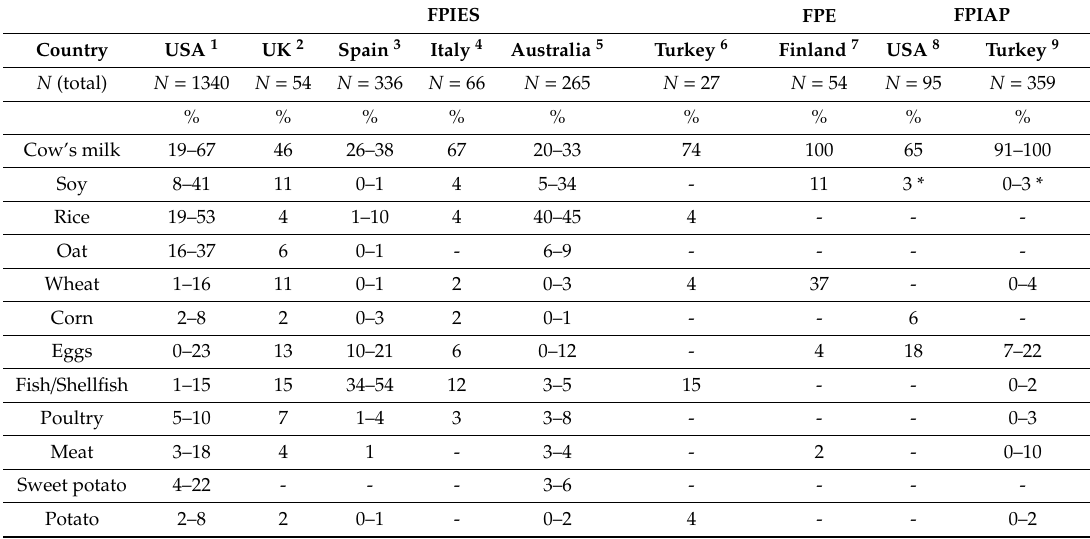
Table 2. Foods commonly implicated in non-IgE-mediated gastrointestinal food allergies in select large case-series